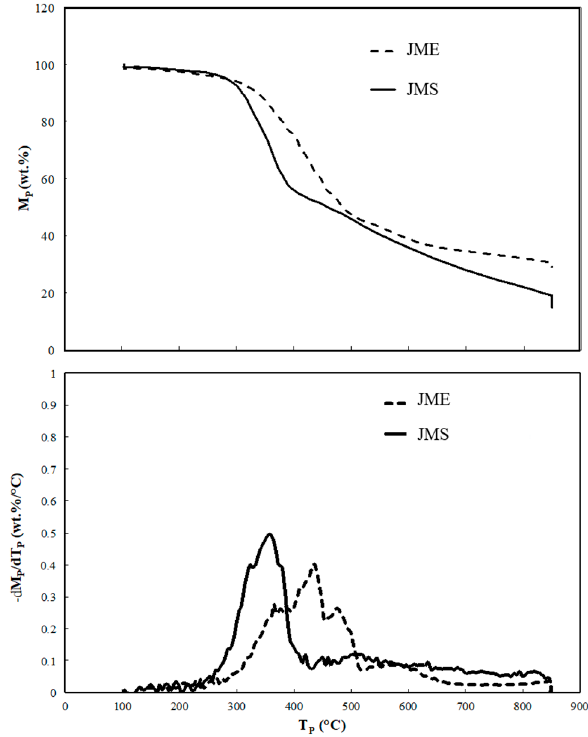
Figure 1. Thermogravimetric analysis (TGA) and derivative thermogravimetric (DTG) curves of JME and JMS. Heating rate = 30 °C/min and N 2 of 50 mL/min. M P and T P : Residual mass fraction and and JMS. Heating rate = 30 ◦ C/min and N 2 of 50 mL/min. M P and T P : Residual mass fraction and temperature during pyrolysis. temperature during